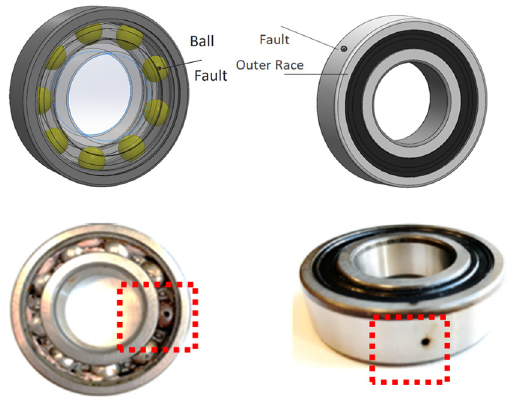
Figure 3. Example of artificially created fault classes on bearings for the in-house dataset.